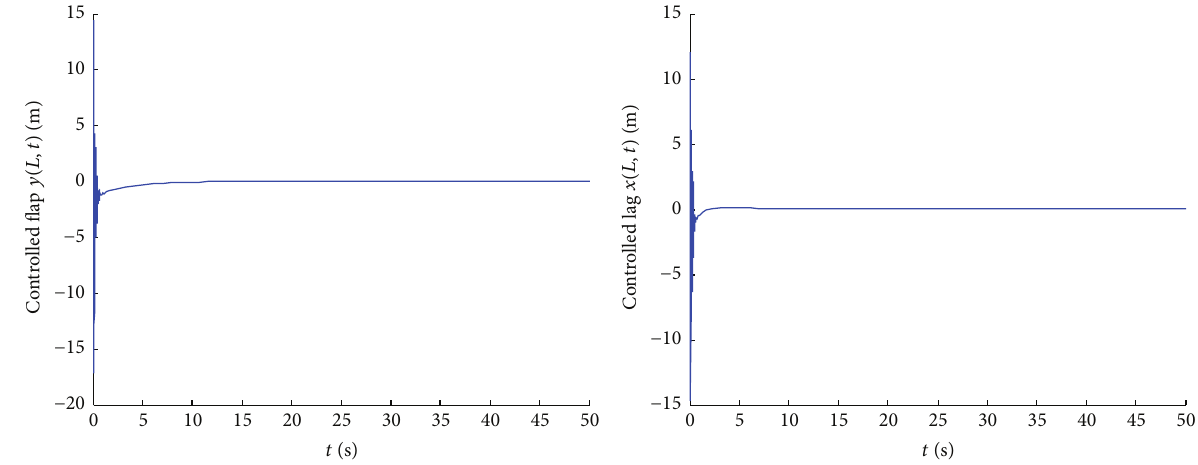
Figure 4: Controlled responses of flap/lag motions under 𝑈 = 65 m/s.